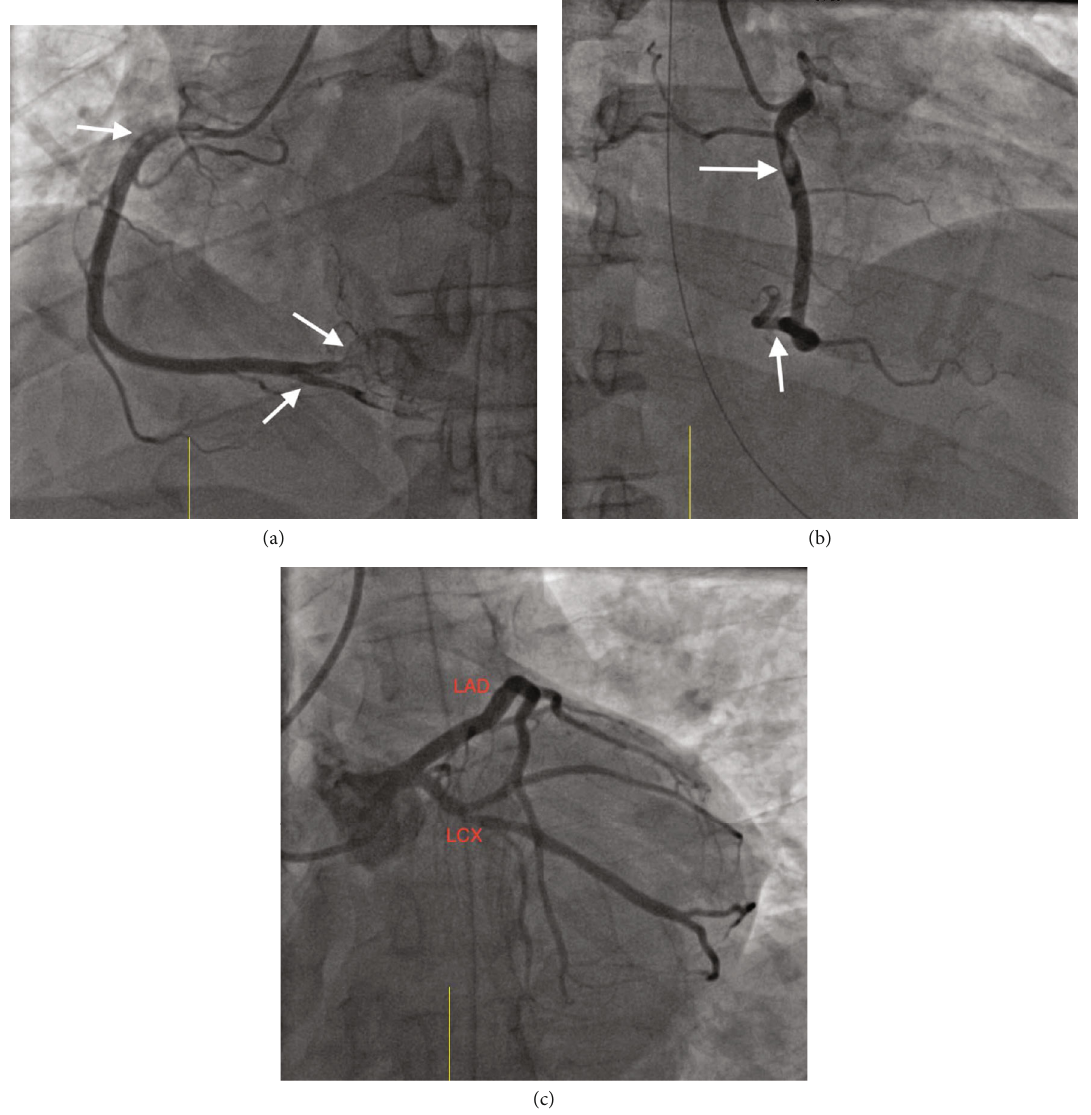
Figure 2: Coronary angiography prior to intervention. (a) pRCA, rPL, and PDA thrombus: coronary angiography (LAO view) showing thrombus in the proximal right coronary artery (pRCA), the right posterolateral (rPL), and the right posterior descending (PDA) branches (white arrows). (b) pRCA and rPL thrombus: coronary angiography (RAO view) showing thrombi in the pRCA and rPL branches (white arrows). (c) Normal left main, LAD, and LCX: coronary angiography (LAO cranial view) showing angiographically normal left main, left anterior descending (LAD), and left circum fl ex (LCX)